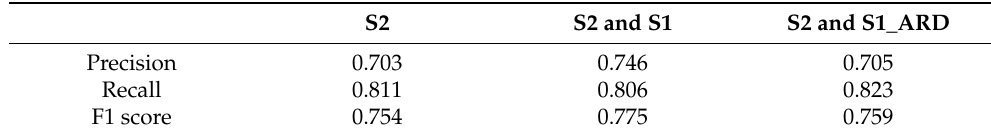
Table 1. Performance assessment of the